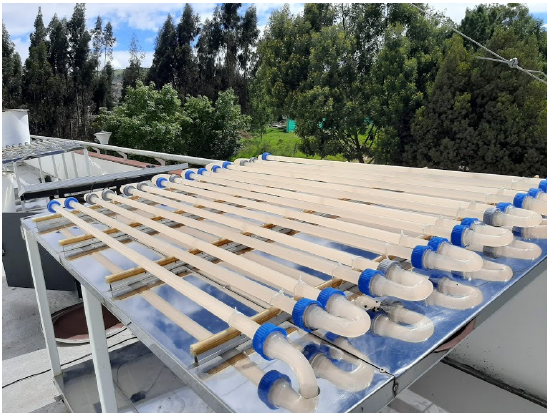
Figure 1. Sunlight reactor for wastewater treatment.